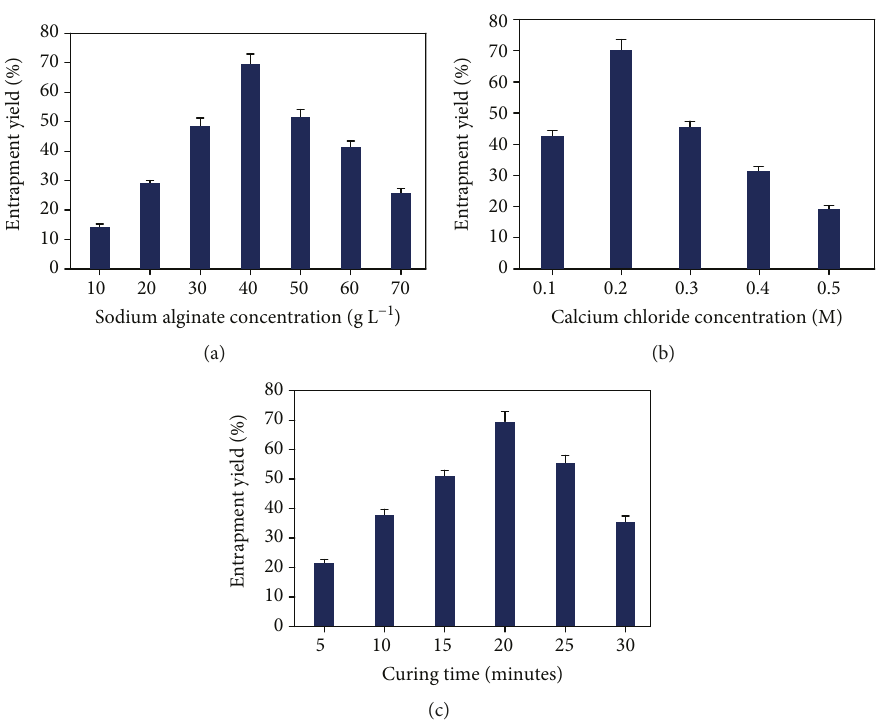
Figure 1: In fl uence of entrapment parameters on the synthesis of alginate spheres and entrapment of dextranase with them: (a) optimization of sodium alginate concentration; (b) optimization of calcium chloride concentration; (c) determination of curing time. All values are shown as mean of three independent experiments ( n = 3